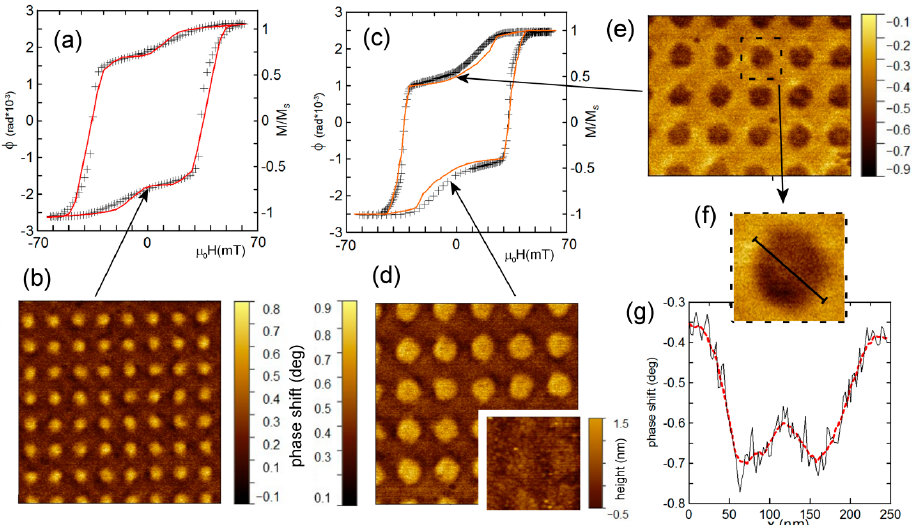
Figure 3. (Color online) ( a ) Hysteresis magnetization loop of the sample with inhomogeneous concentric He + ion fluence (sample No. 2, spot diameters are D 1 = 80 nm, D 2 = 100 nm). Crosses show the experimental data on the polar magneto-optical Kerr e ff ect and the solid red line is the magnetization loop obtained using numerical simulations. ( b ) MFM image of the remnant magnetic state of the sample No. 2. The scan width is 1.6 μ m. ( c ) Hysteresis magnetization loop of the sample No. 3 (spot diameters are D 1 = 180 nm, D 2 = 200 nm). Crosses are the experimental MOKE data. The solid orange line is the magnetization loop obtained using numerical simulations. ( d ) MFM image of the remnant magnetic state of the sample No. 3. The scan width is 1.6 μ m. Inset represents AFM image with the size of 0.8 μ m. ( e ) MFM image of the reversed remnant magnetic state of the sample No. 3. The scan width is 1.6 μ m. ( f ) The close view of a single spot. ( g ) The profile of the MFM signal along the line in ( f ). The black curve is the experimental data and the red dashed line is the averaged signal.